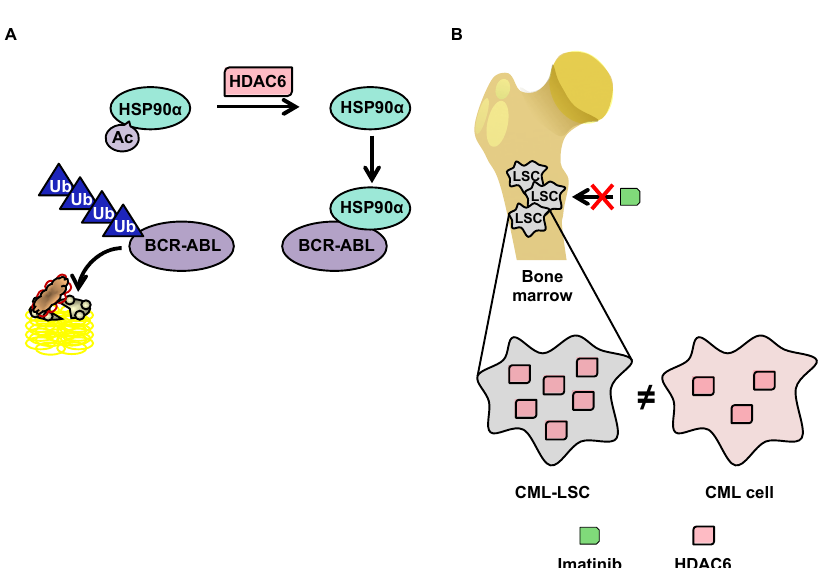
Figure 6. Role of HDAC6 in chronic myeloid leukemia. ( A ) HDAC6 is implicated in proteasome-dependent protein degradation by its interaction with HSP90 α , a chaperone protein which, when deacetylated by HDAC6, is involved in the stabilization of BCR-ABL. In its acetylated (Ac) form, HSP90 α loses its chaperone function, which leads to ubiquitination (Ub) and subsequent degradation of BCR-ABL by the proteasome. ( B ) Imatinib-insensitive chronic myeloid leukemia (CML) leukemic stem cells (LSCs) overexpress HDAC6 compared to CML cells.